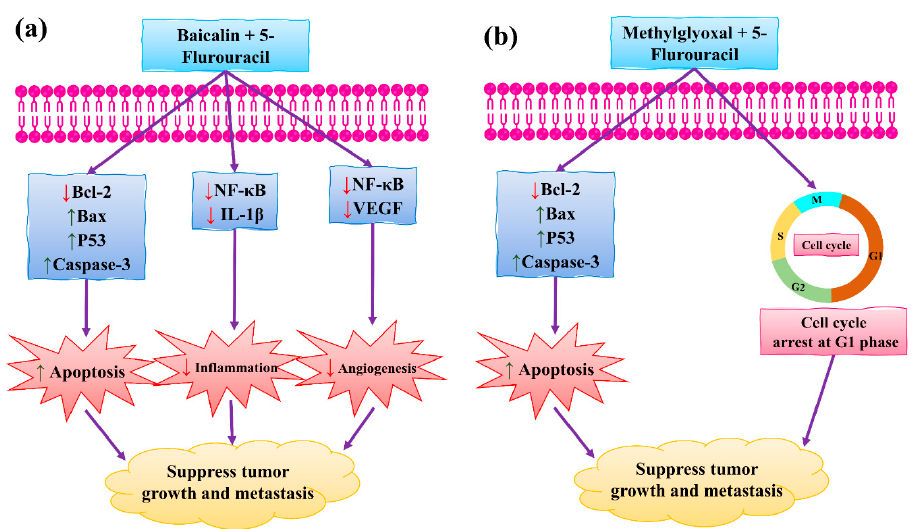
Figure 9. The synergistic effect of ( a ) BA and 5-FU, and ( b ) MG and 5-FU in BC therapy. BCL2: B-cell lymphoma two protein; NF- κ B: nuclear factor kappa B; Bax: Bcl-2-associated X protein; p53: inducible gene 3; IL-1 β : interleukin 1 beta; VEGF: vascular endothelial growth factor. This figure is reproduced from Shehatta et al. [106] (Attribution Non-Commercial No. Derivatives 4.0 International (CC BY-NC-ND 4.0)).